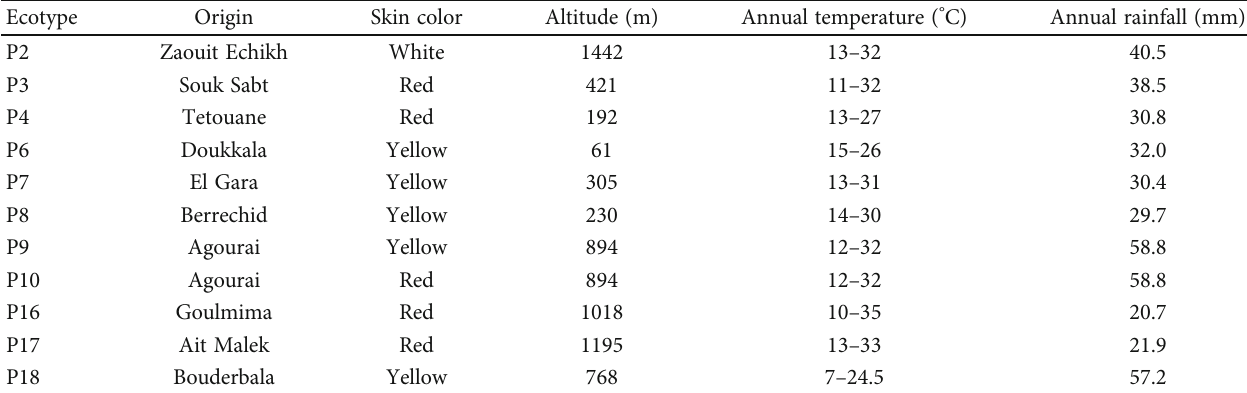
Table 1: Geographic origin, altitude, annual temperature, and annual rainfall of collected onion ecotype